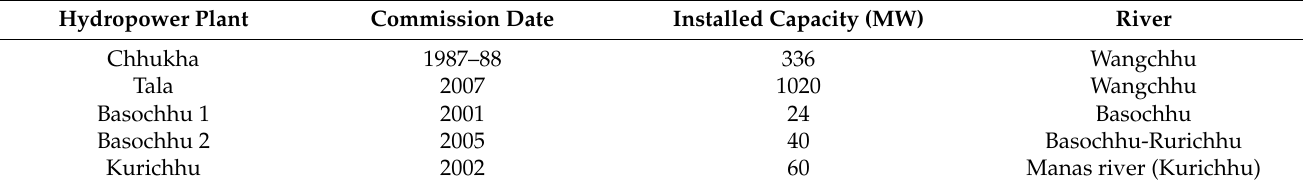
Table 1. Existing hydropower plants in Bhutan (source: Ministry of Economic Affairs (2018) [64]). Hydropower